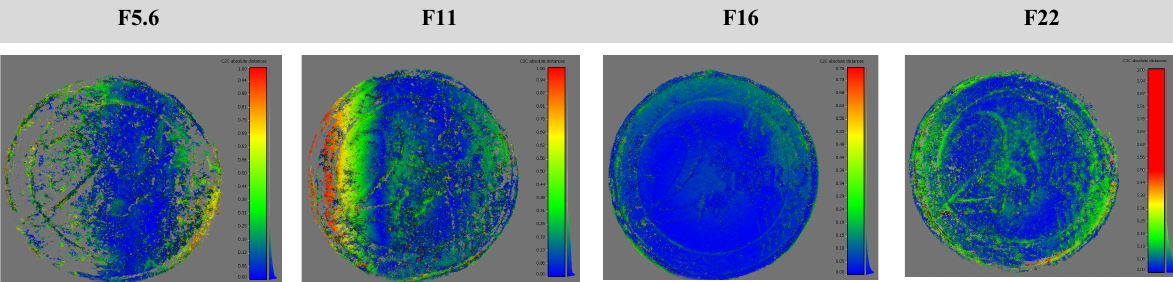
Figure 4. Cloud-to-Cloud comparison [mm] with F5.6, F11, F16 and F22 for the 2-euro case study. Range [0/1 mm].